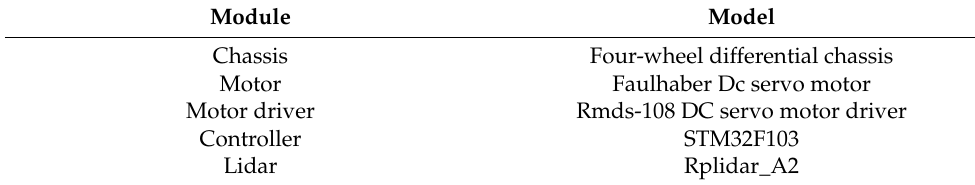
Table 1. The main components and models of the robot.